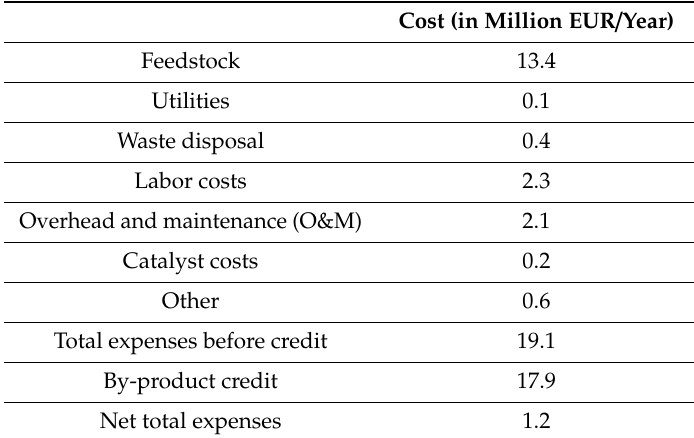
Table 2. Operating costs for pyrolysis plant using Cs / ASA as a catalyst for